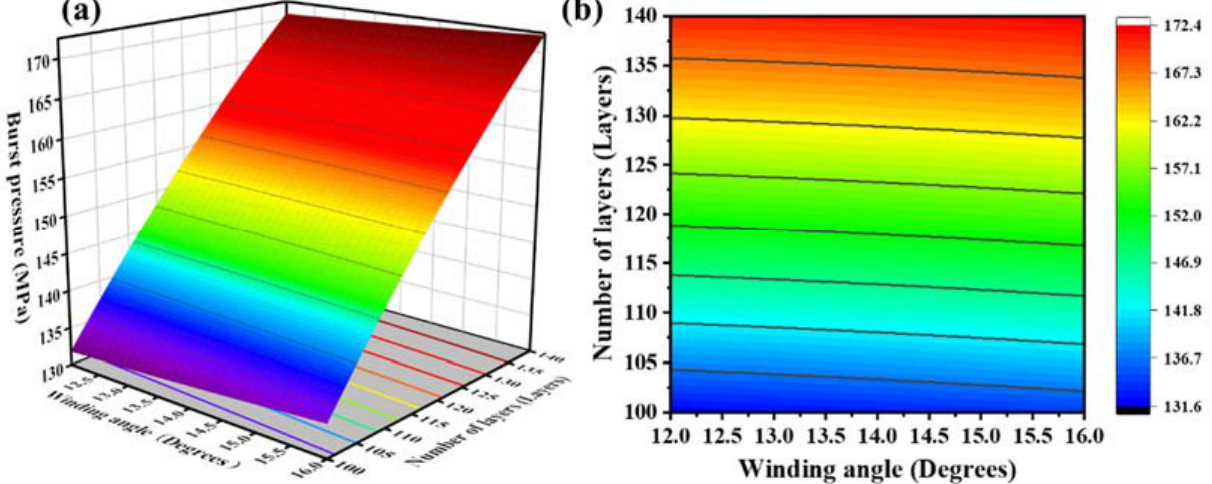
Figure 8. ( a ) Response surfaces of the effect of the helical/hoop ratio and the number of layers on blasting pressure; ( b ) contour plot of the effect of the helical/hoop ratio and the number of layers on blasting pressure.